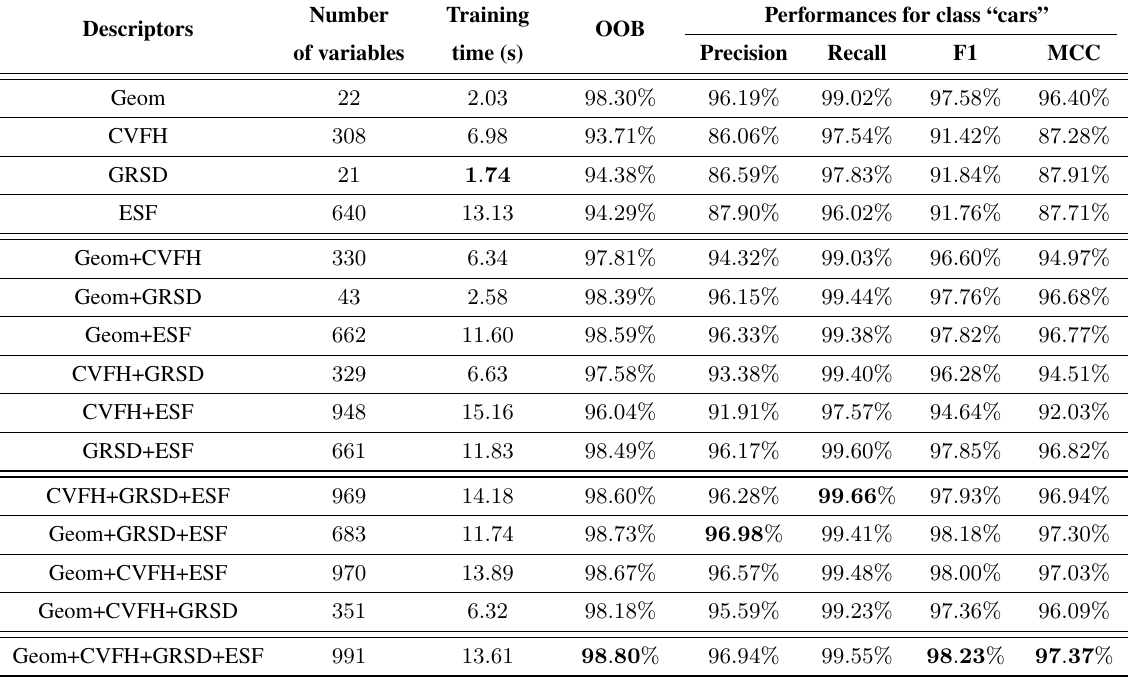
Table 4: Performances for each combination of descriptor possible (Geom is for Geometric features, for each column the best result is in bold )